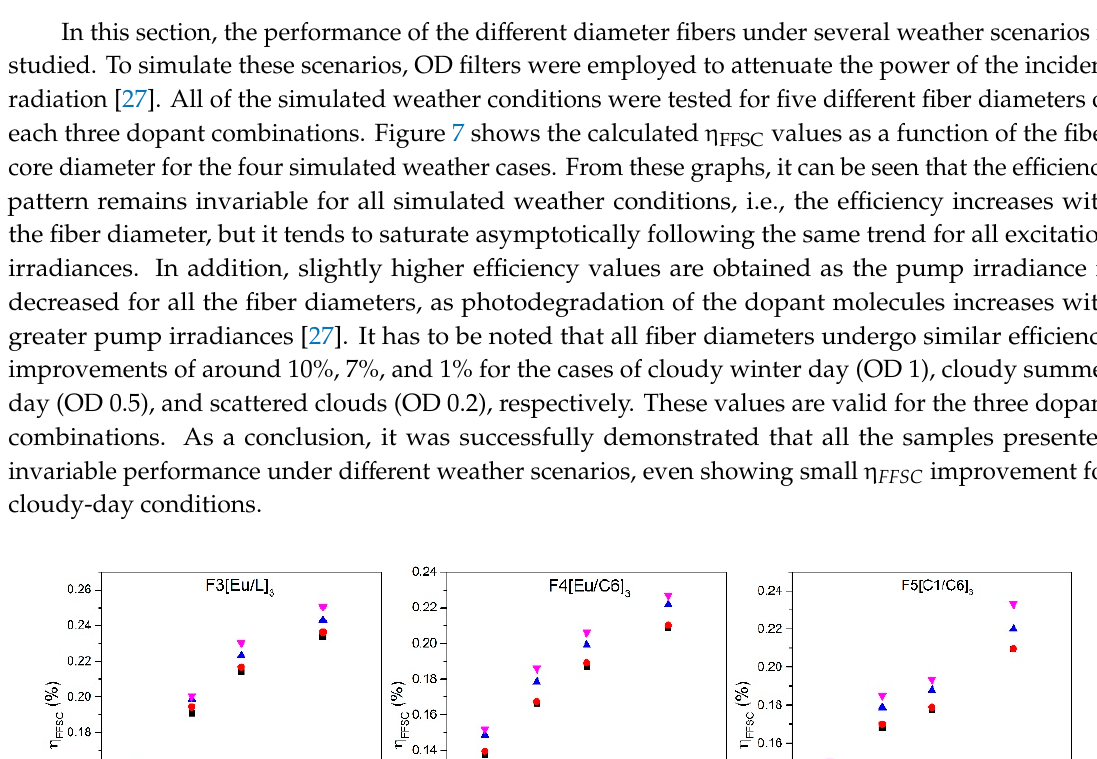
Figure 6. Output power ( a ); output irradiance ( b ), and η FFSC ( c ) for the three double-doped samples as functions of the fiber core diameter. Symbols: experimental data; solid lines: fittings of Equation (2). The relative errors for the output power, output irradiance and η FFSC are 4%, 3% and 1%, respectively.